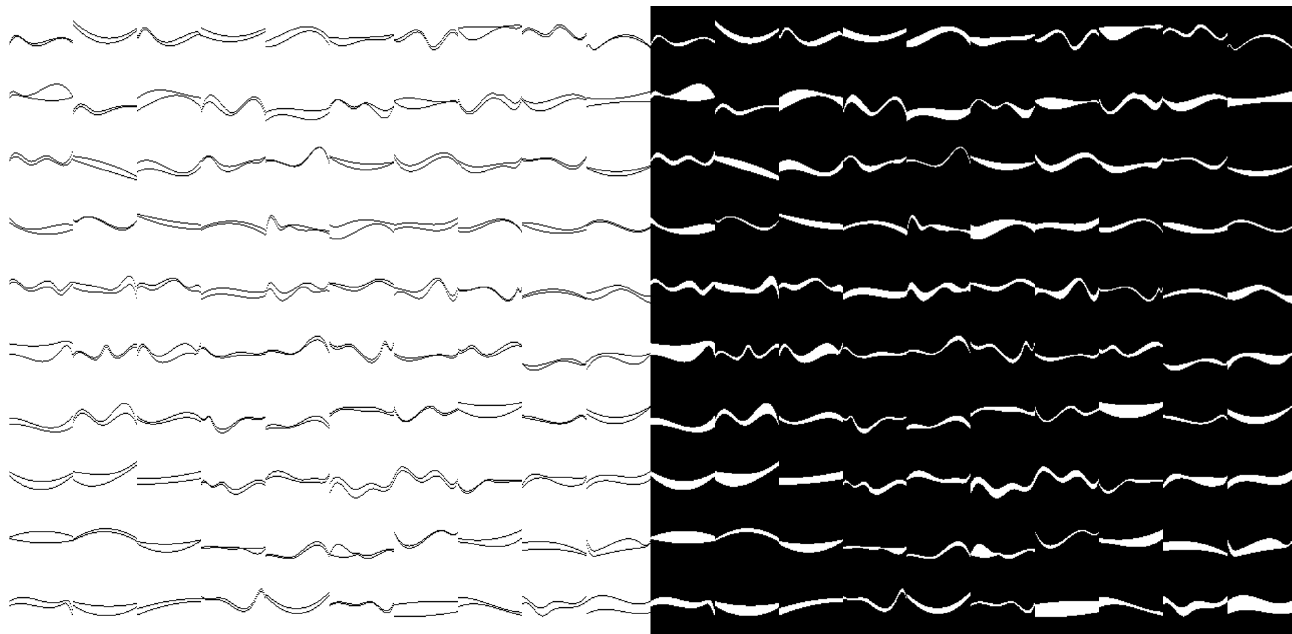
Fig. 3. Part of an artificial dataset of curvilinear meandering regions, where the regions appear “more” curvilinear (the stripe can have one to five bends) yet narrower than in Fig. 2. The seeming simplicity for SIS is ignored because the complete separation of the image by the region of interest cannot be known or predicted in advance, and thus the 100 % transparency of the region may become a serious difficulty in fulfilling SIS. Such datasets will be used for the study.